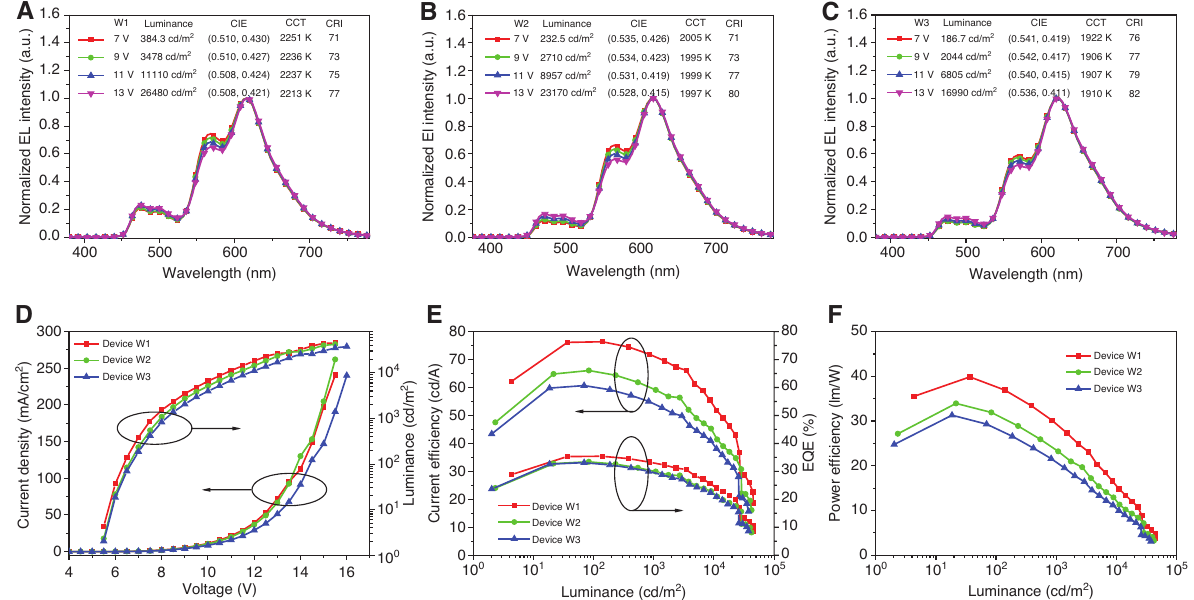
Figure 7: (A–C) The EL spectra of tandem white devices W1–W3, and luminance, CIE coordinates, CCT, and CRI of these devices at different voltages are also listed; (D–F) The J-V-L (D), CE-L-EQE (E), and PE-L curves of tandem white devices W1–W3.